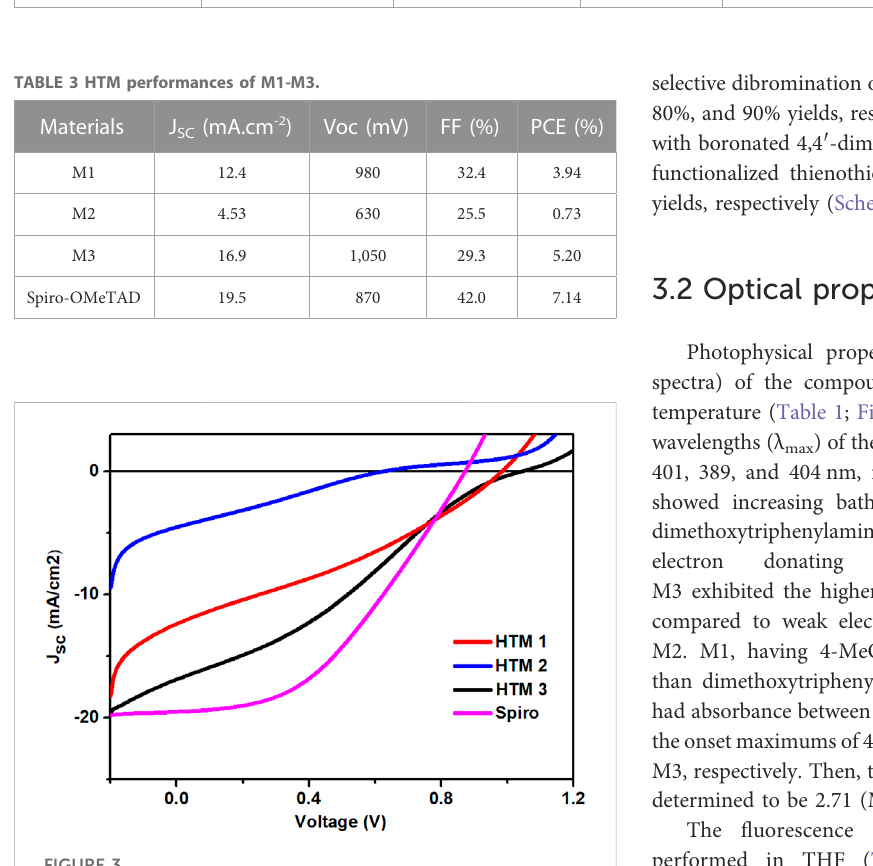
Current (J) – voltage (V) curves of the solar cells with HTM 1-3 (M1-M3) and